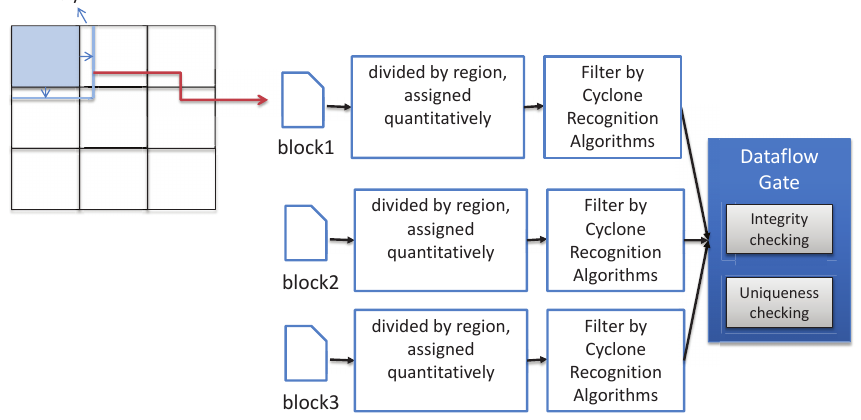
Figure 4. Cyclone recognition